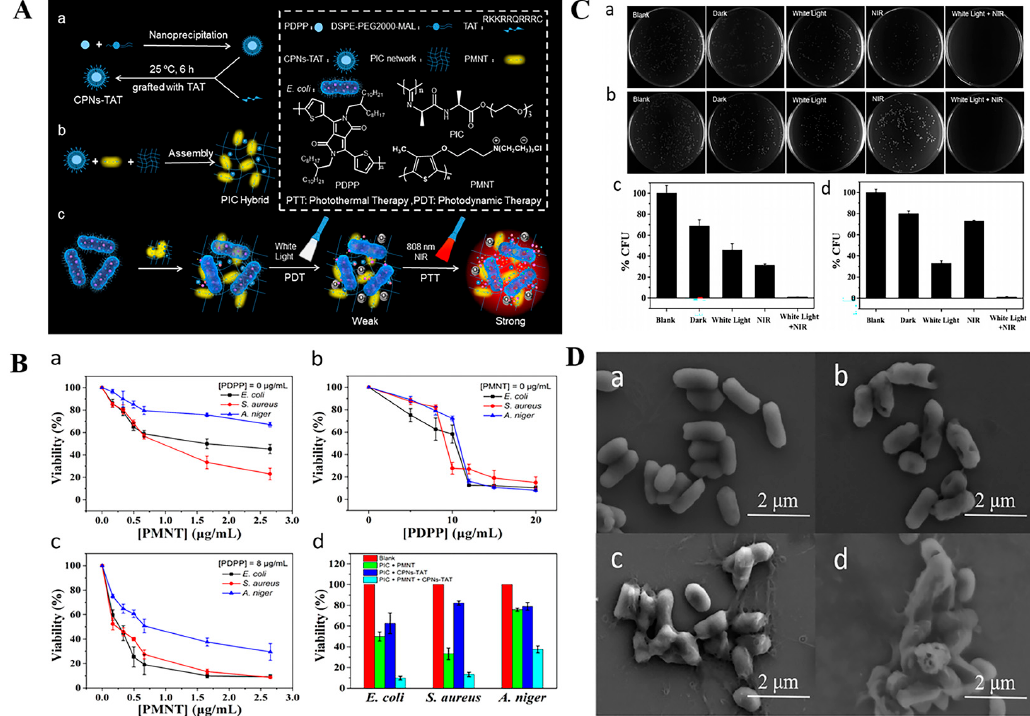
Figure 10. ( A ) Schematic illustration of the polyisocyanide (PIC)-based hybrid hydrogel for syner- gistic antibacterial application of photodynamic therapy (PDT) and photothermal therapy (PTT) under both white and NIR light irradiation. ( B ) In vitro growth inhibition of various hybrid hydro- gel against E. coli, S. aureus , and A. niger ( a ) under white light irradiation; ( b ) under NIR light irra- diation; ( c ) under white light and NIR light irradiation; and ( d ) histogram of the inhibition effects. ( C ) In vitro antibacterial effect of the PIC hybrid hydrogel against E. coli and S. aureus under different light sources using standard plate counting method. ( D ) SEM images of E. coli after different treat- ments: ( a ) incubated with the PIC hydrogel without any light irradiation; ( b ) incubated with the PIC/CPNs-TAT complex without any light irradiation; ( c ) incubated with the PIC/PMNT complex with white light irradiation; ( d ) incubated with the PIC hybrid with white light and NIR light irra- diation. Reprinted from ref [208]. Copyright 2020 American Chemical Society. 3. Intelligent Nanomaterials-Based Wound Dressings for Infection Detection and Treatment Apart from antibacterial therapy, timely detection of bacteria at the wound site is of great importance for antibacterial wound dressings to provide appropriate and efficient anti-infection treatments. Currently, clinical detection of wound infection is usually per- formed by removing covered dressings, scraping wound exudates for further pathogen detection and by visual diagnosis based on some obvious clinical symptoms, including redness, swelling, pustule, and heat. The infections easily induce secondary wound dam- age [214,215]. Frequent changes of dressings may also induce secondary wound injury and increase pain in patients. Therefore, developing intelligent wound dressings that are capable of both detecting bacterial infections in-situ and providing timely antibacterial therapies for infection control is of great significance. Such wound dressings may over- come the disadvantages of traditional clinical approaches for infection detection and markedly improve the therapeutic outcomes as well as innovate management models for wound infections. Currently, intelligent wound dressings that simultaneously integrate wearable sensors and advanced drug delivery systems have achieved tremendous ad- vances in wound infection diagnosis and treatment [215–218]. The unique optical and